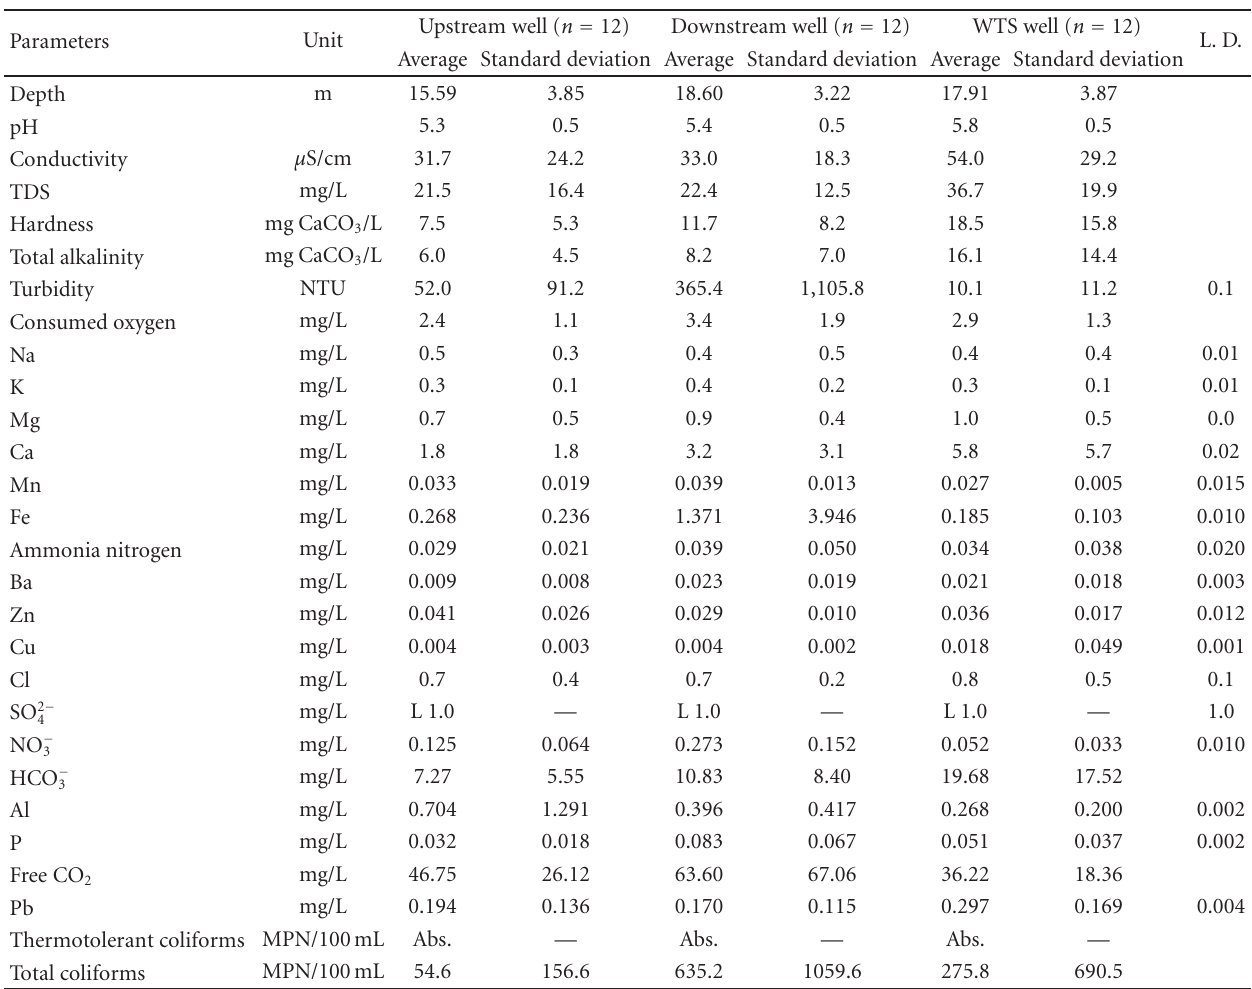
Table 5: Results of water